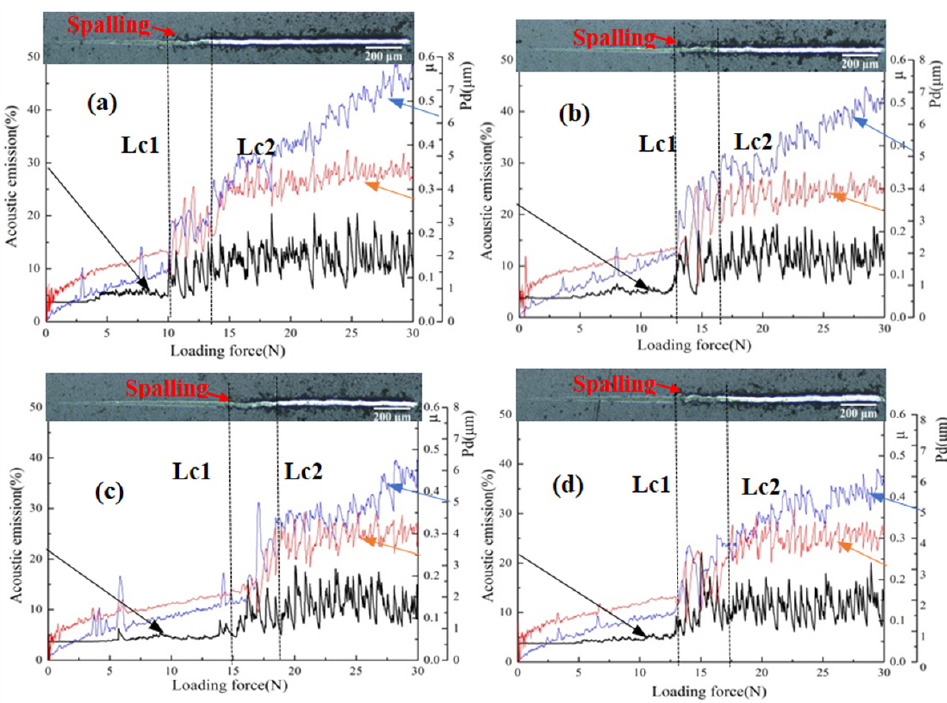
Figure 5. The scratch test results of ( a ) TiAlN/WT1, ( b ) TiAlN/WT2, ( c ) TiAlN/WT3 and ( d ) TiAlN/WT4 coated cemented carbides.